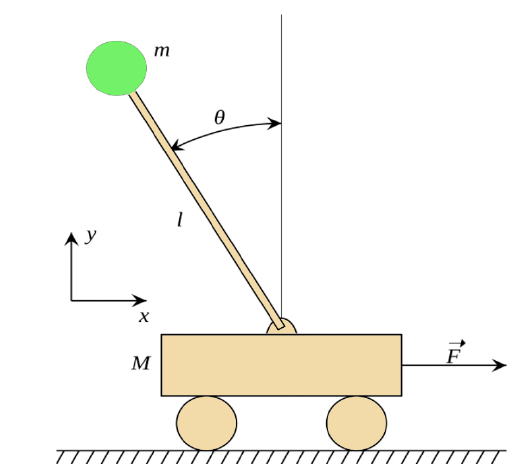
Figure 1. Inverted pendulum on a cart